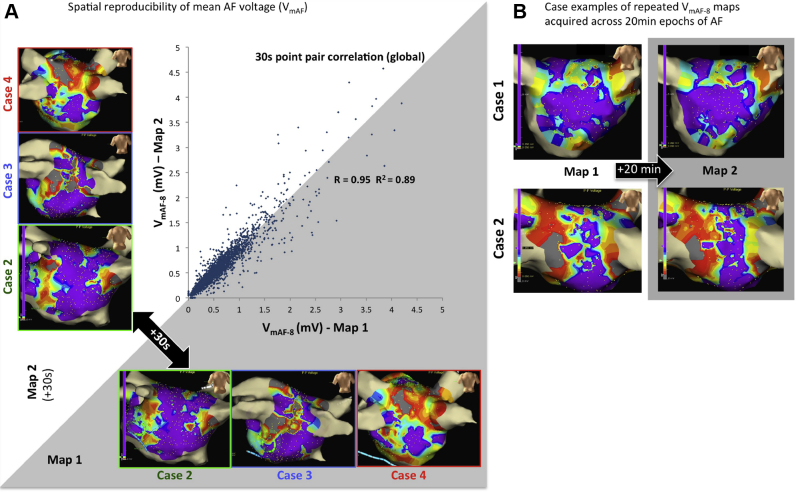
Spatial reproducibility of mean atrial fibrillation (AF) voltage. A: Global correlation (15 patients; 3450 locations) of VmAF point-pairs acquired 30 seconds apart. Cases 2, 3, and 4 demonstrate congruency of the individual maps. B: Two case examples of 8-second VmAF maps (5-mm interpolation) acquired sequentially, separated by a 20-minute waiting period.